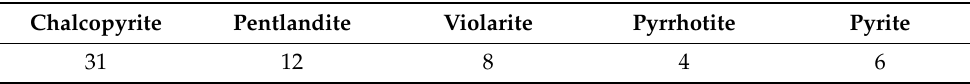
Table 2. Sulfide mineral content (wt%) in concentrate. Chalcopyrite Pentlandite Violarite